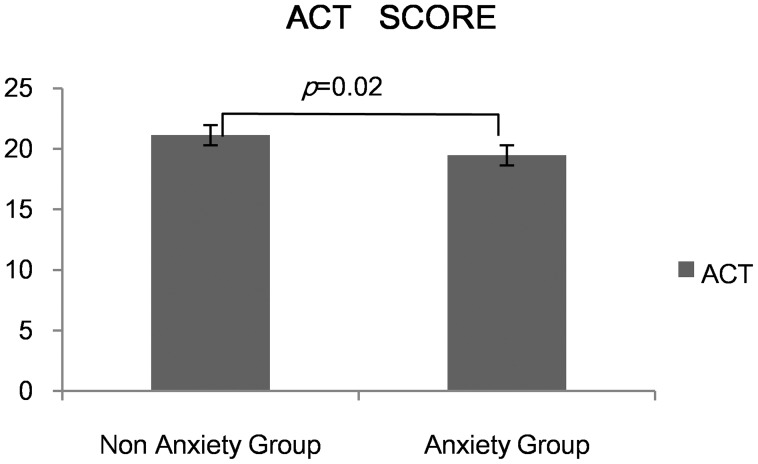
ACT score between Anxiety and Non anxiety group.